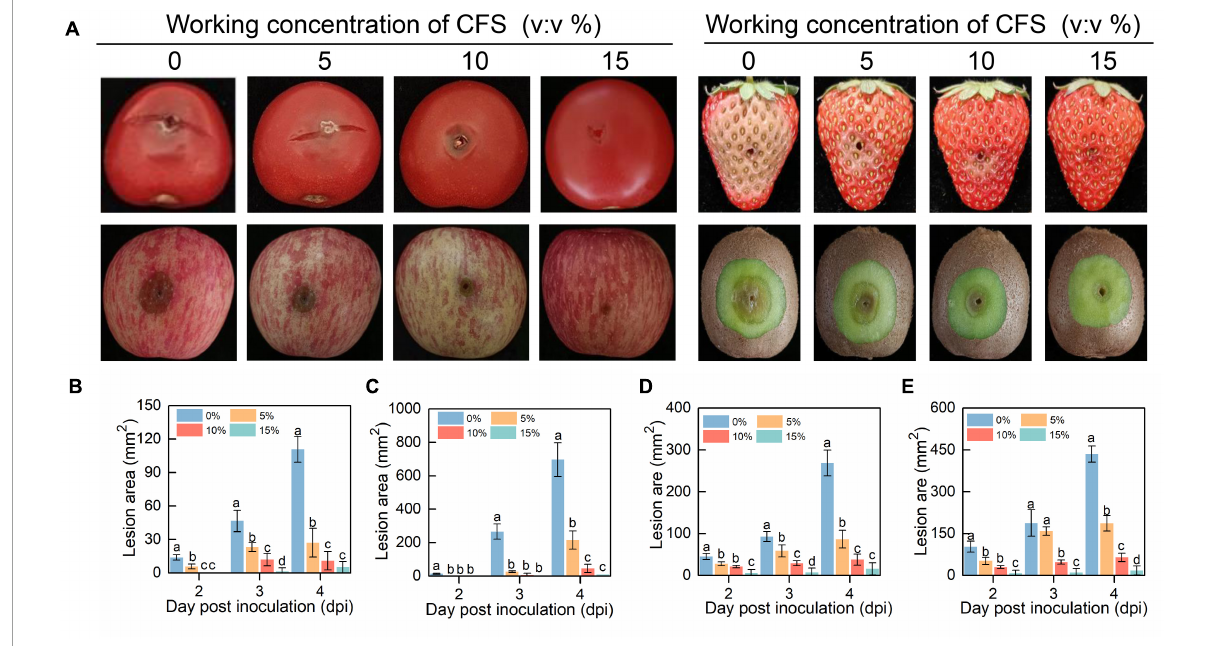
FIGURE2 The efficacy of cell-free supernatant (CFS) on pathogenicity of Botrytis cinerea on postharvest fruits. (A) Photographs of diseased fruits were taken 4 days after treatment. Lesion area on harvested cherry tomato (B) , strawberry (C) , apple fruit (D) and kiwifruit (E) were measured by using Image J. Histograms with different letters at each time point indicate significant differences according to Duncan’s multiple range tests at p <